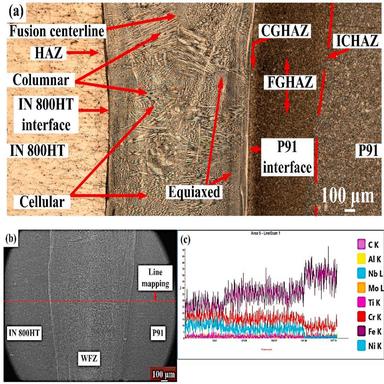
(a) Stitched optical micrographs of electron beam weld; (b–c) EDS line map spectrum across the weld bead.